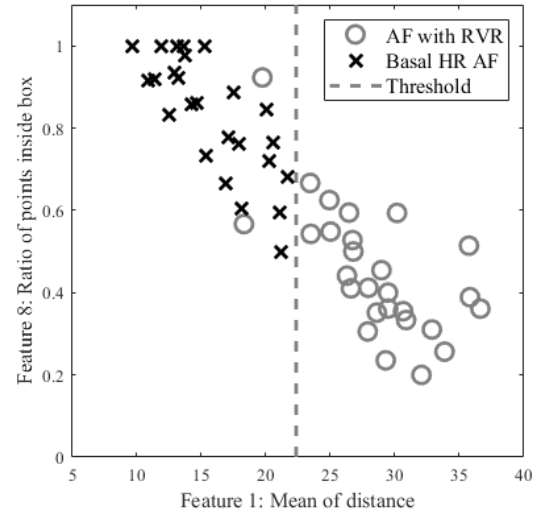
Figure 5. Scatter plot of candidate features for heart rate estimation among individuals with AF stratified by high vs. basal ventricular response. The X axis is the best feature value of mean of distance calculated from the Poincaré plot of heart rate difference; the Y axis is the second-best feature value of ratio of points inside a confined box from a Poincaré plot of heart